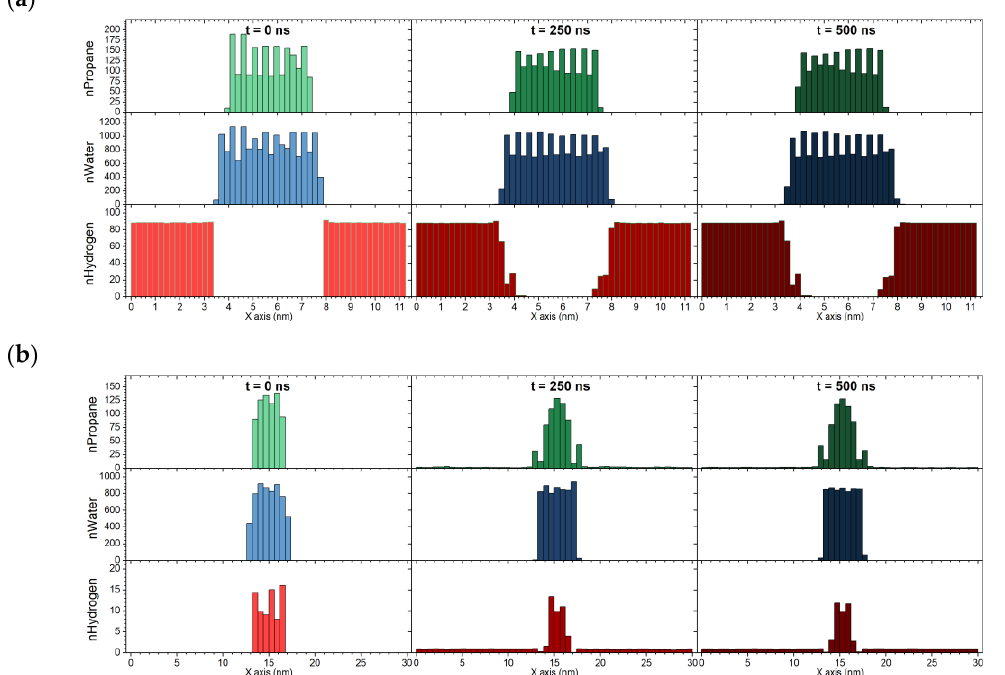
Figure 4. Density map of propane, water, and hydrogen molecules along the X-axis for uptake ( a ) and release ( b ).